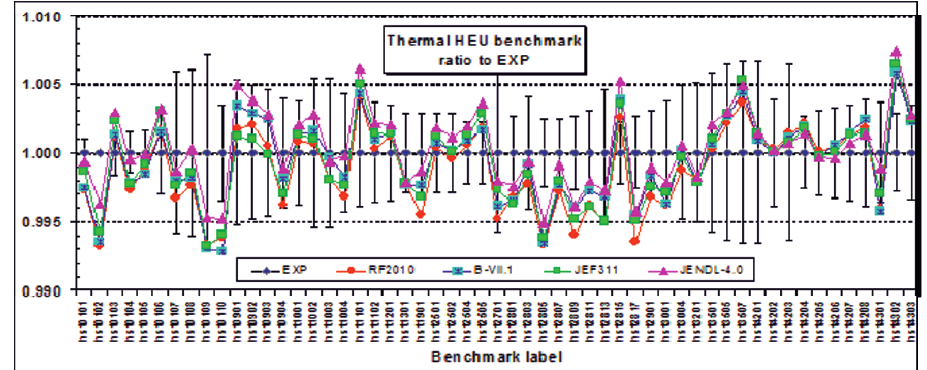
Fig. 3: Thermal HEU benchmarks.